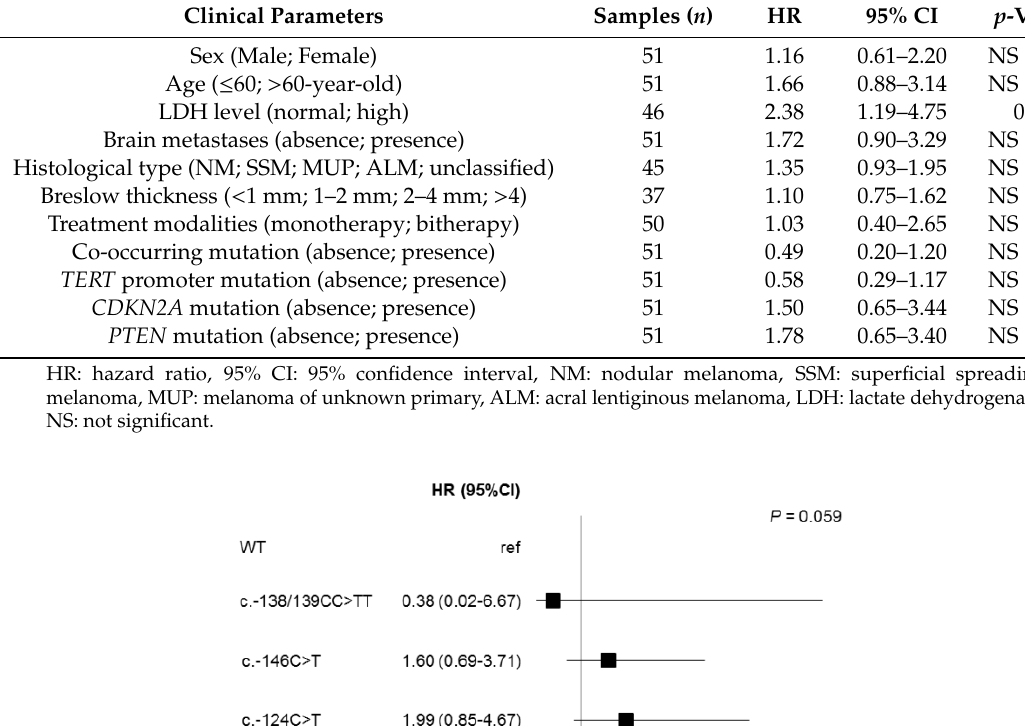
Figure 4. Effect of TERT c.-124C>T mutation on clinical outcome of BRAF V600 patients with or without brain metastasis. ( A ) Kaplan–Meier analyses of PFS in patients with brain metastasis in function of the TERT c.-124C>T mutation status. ( B ) Kaplan–Meier analyses of PFS in patients without brain metastasis in function of the TERT c.-124C>T mutation status. These observations prompt us to evaluate signatures that combine the TERT mutation status with other prognostic markers. Thus, patients with brain metastasis in absence of TERT c.-124C>T mutation had a worse outcome than other patients ( p = 0.003, Figure 5A). This signature was identified as the best fit for predicting worse clinical outcomes (likelihood = 243.55), relative to the model with the brain metastasis status alone or the TERT mutation status alone (likelihood = 248.01